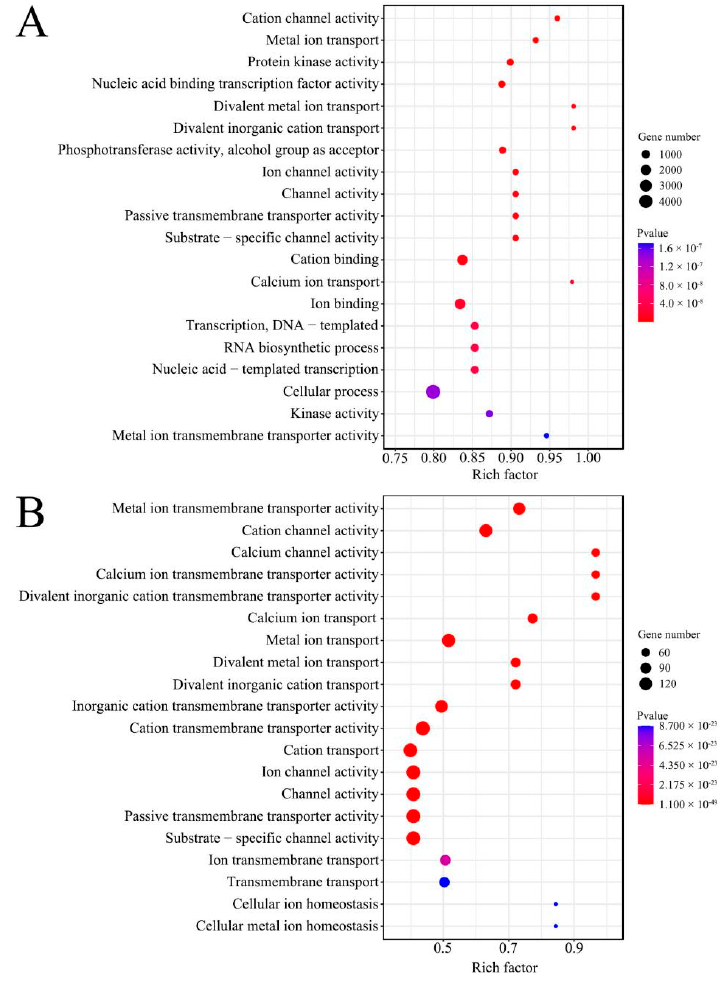
Figure 3. Top 20 GO terms that were annotated by target genes of DEpiRNAs in the “Am4 vs. Am5” ( A ) and “Am5 vs. Am6” ( B ) comparison groups. Circle size increases with the number of target genes, circle color depth increases significantly with p -value.